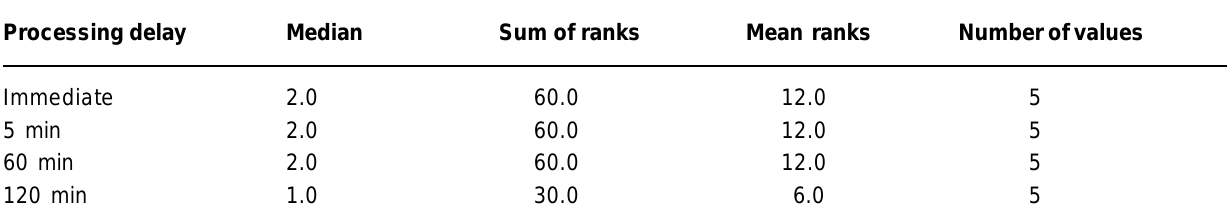
Hc= 10.05882; Chi-square with 3 degrees of freedom; Probability = 0.018072 (significant) TABLE 3- Mann Whitney test for analysis of the processing delay of optical plates protected with opaque cases